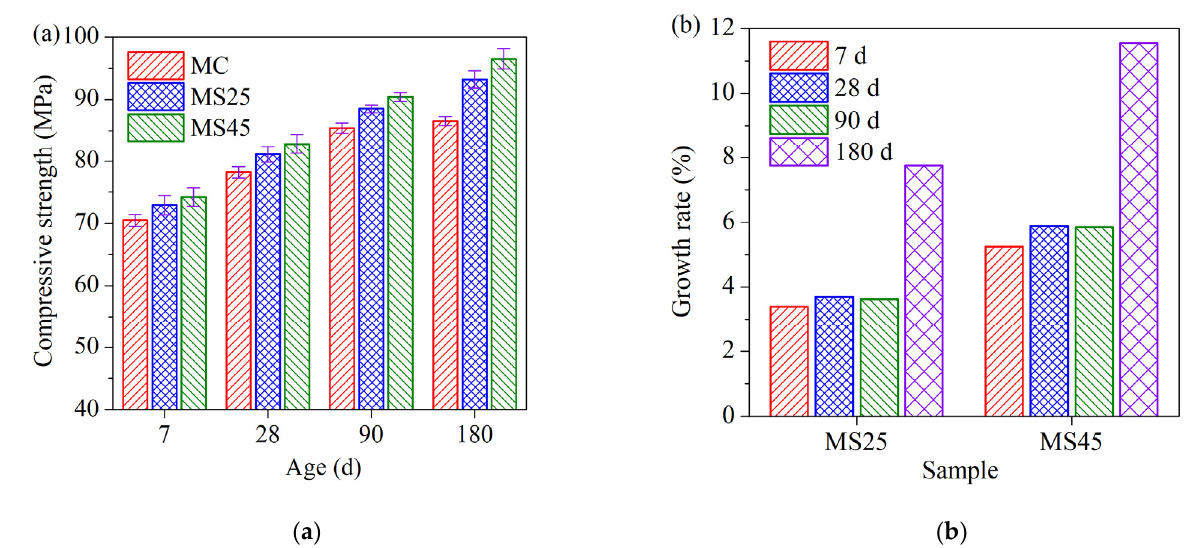
Figure 3. ( a ) Compressive strength of high-strength concrete under temperature-matching curing conditions; ( b ) growth rate of compressive strength at different ages.